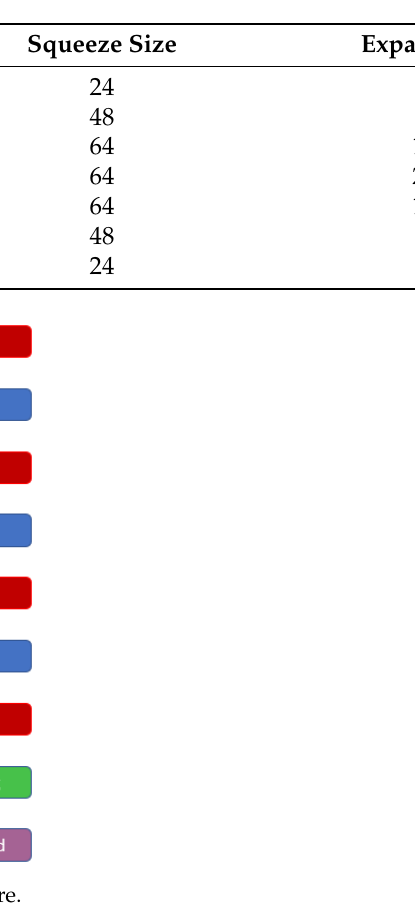
Table 2. Fire modules.